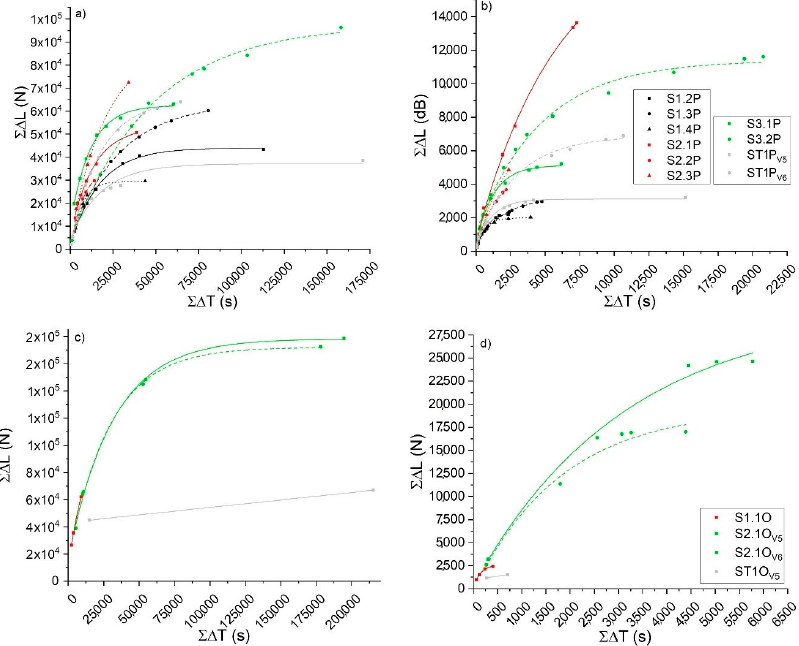
Figure 7. ΣΔ T (s) vs. ΣΔ L (N) plots of the tested samples and obtained best fits. ( a ) Pine, load increase; ( b ) Pine, load decrease; ( c ) Oak, load increase; ( d ) Oak, load decrease. Table 2. Total expected lifetime for the ductile-like (DL) and brittle-like (BL) state for the simil-CT oak and pine samples and the best fit of lifetime versus load decrease (BL fracture mechanism). V5, Vallen sensor number 5; and V6, Vallen sensor number 6.